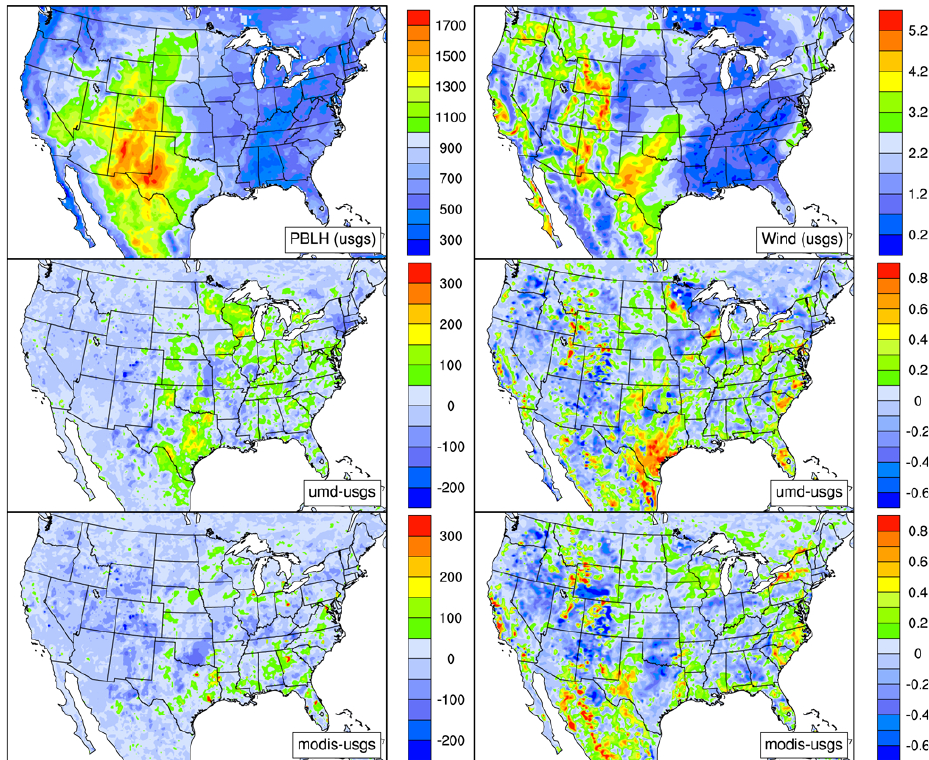
Fig. 6. Same as Fig. 3 except for average PBL height (PBLH, m, left panels) and surface wind speed (ms − 1 , right panels).